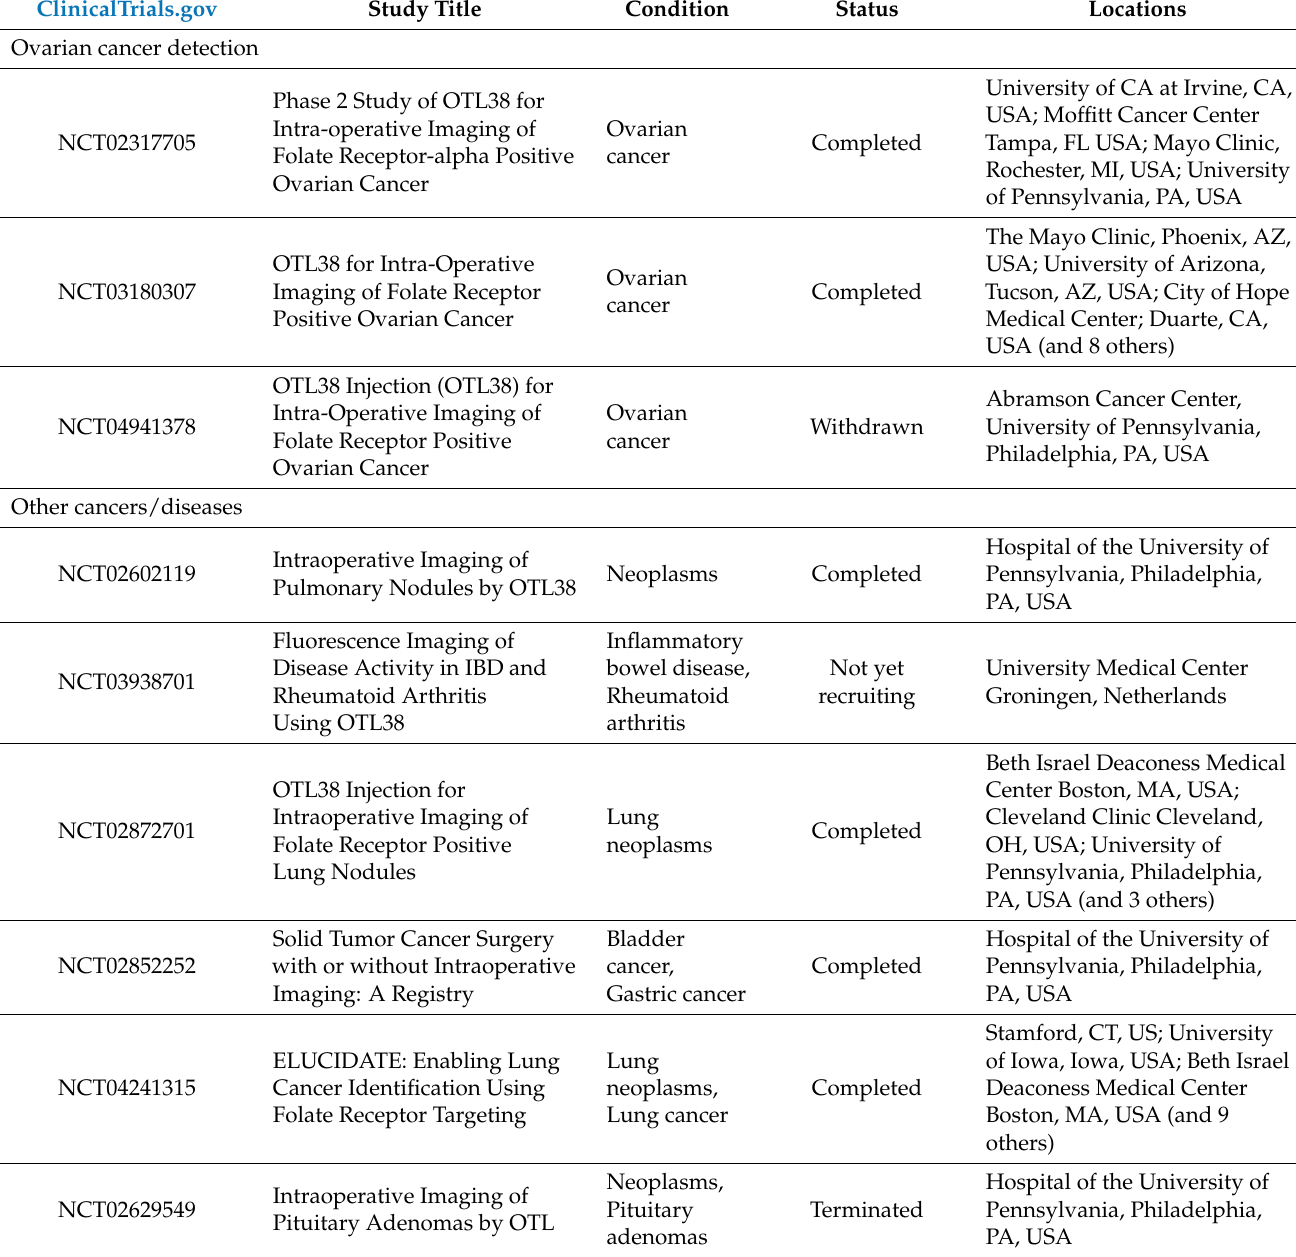
Table 1. Clinical trials with pafolacianine for intraoperative cancer detection.